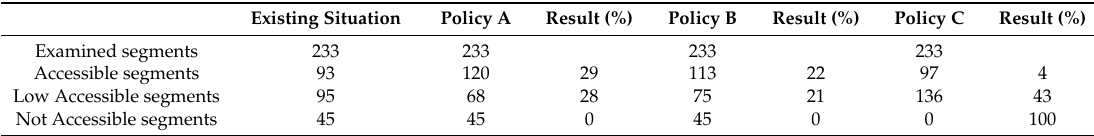
Table 4. The results of the policy changes (a, b, c) on